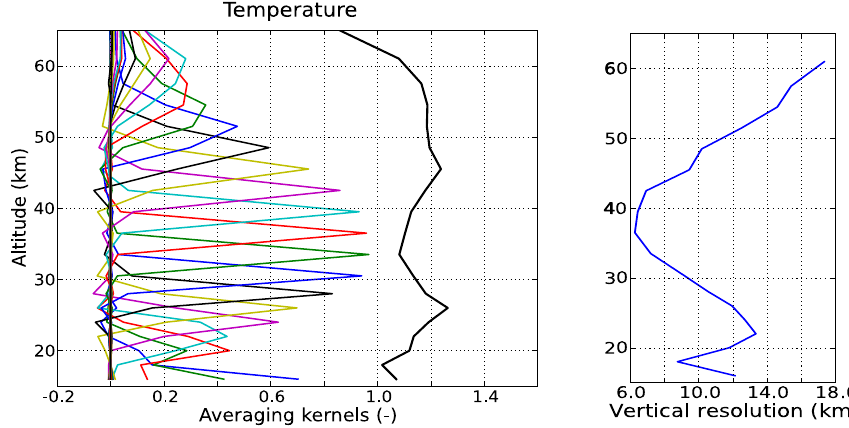
Fig. 11. Same as Fig. 8 but for the retrieved temperature profile.